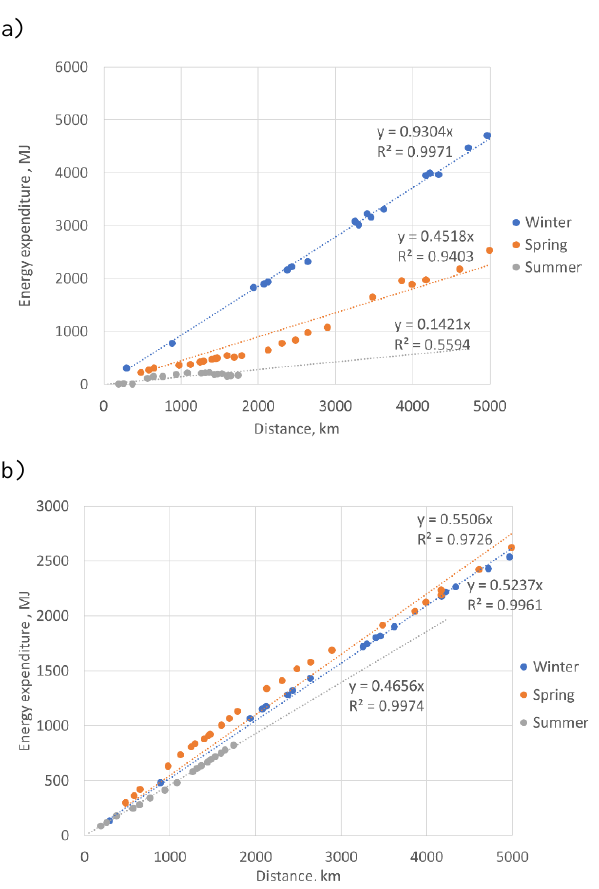
Fig. 5. Energy expenditure for distances of about 50 km in relation to the total mileage of the vehicle in the tested period, divided into individual drives: a) internal combustion engine, b) electric